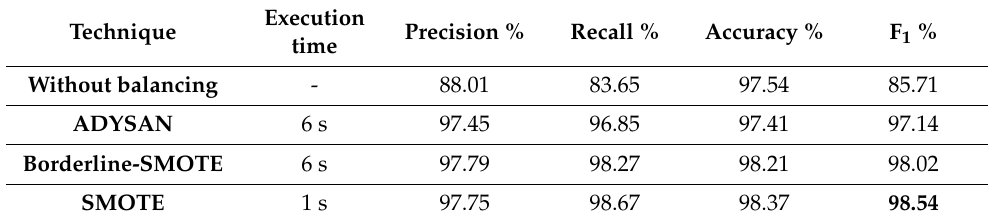
Table 5. Comparison of the effects of different balancing techniques on the model performance. Technique